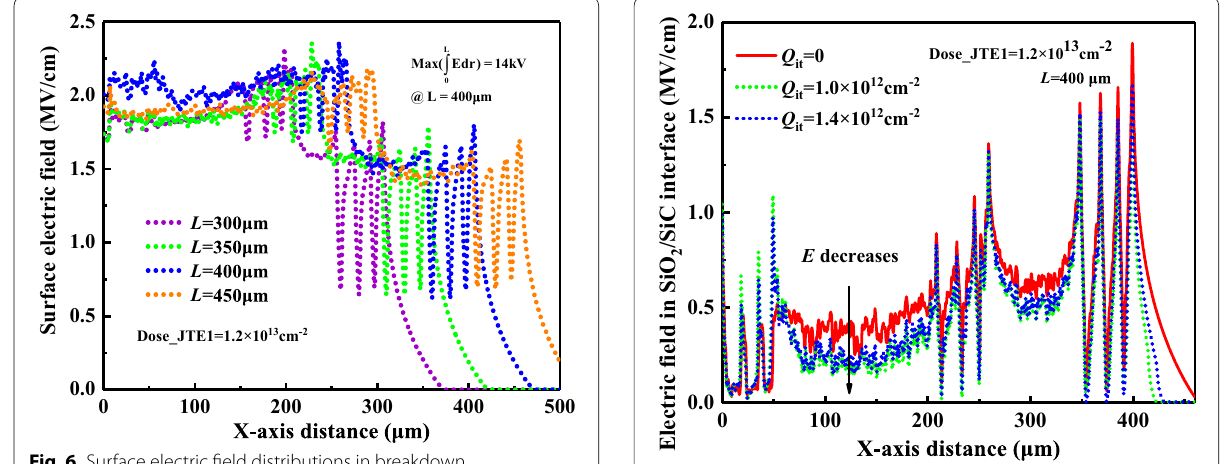
Fig. 8 Electric field distributions in SiO 2 /SiC interface with different Q